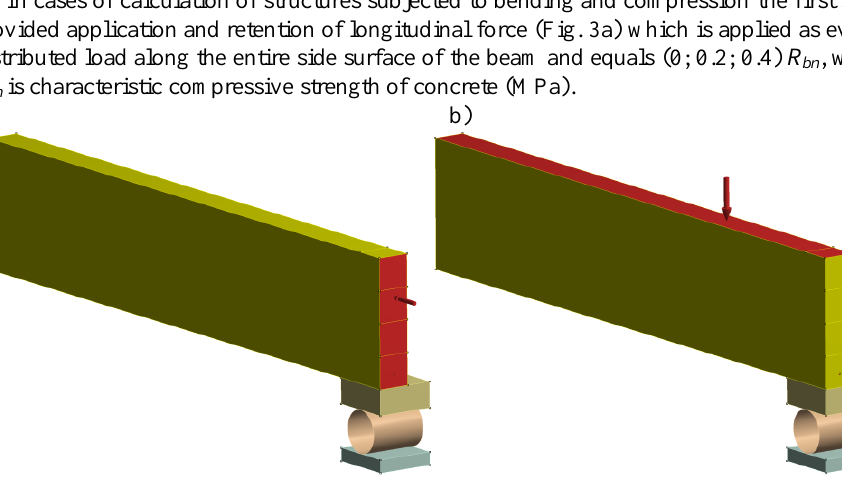
Fig. 3. Load application: a – longitudinal static load; b – transverse dynamic